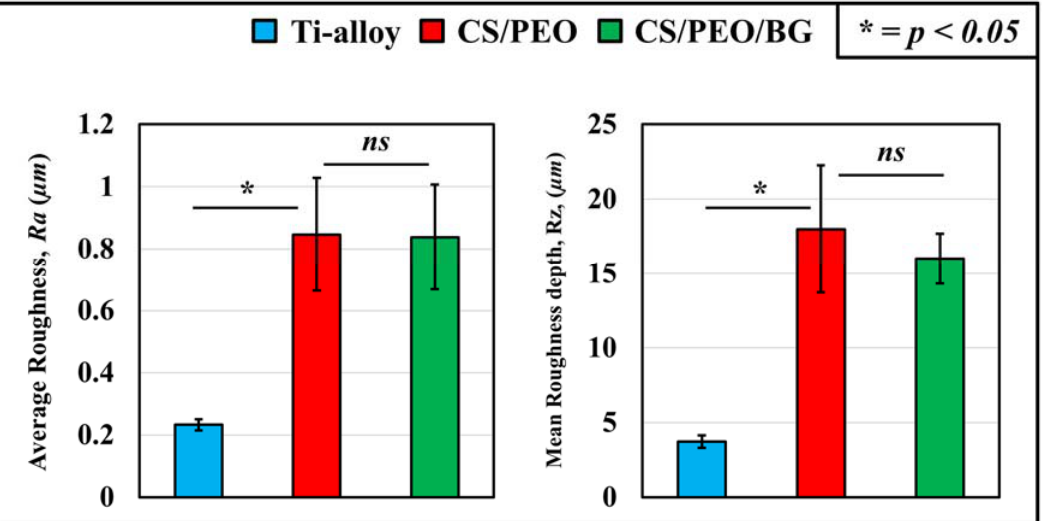
Figure 6. Comparison of roughness parameters, Ra and Rz of the substrates samples; the values are obtained calculating the parameter in 25 images collected at 150X on each surface substrates labeled with three different color ( ns = non ‐ significant; p < 0.05 ).